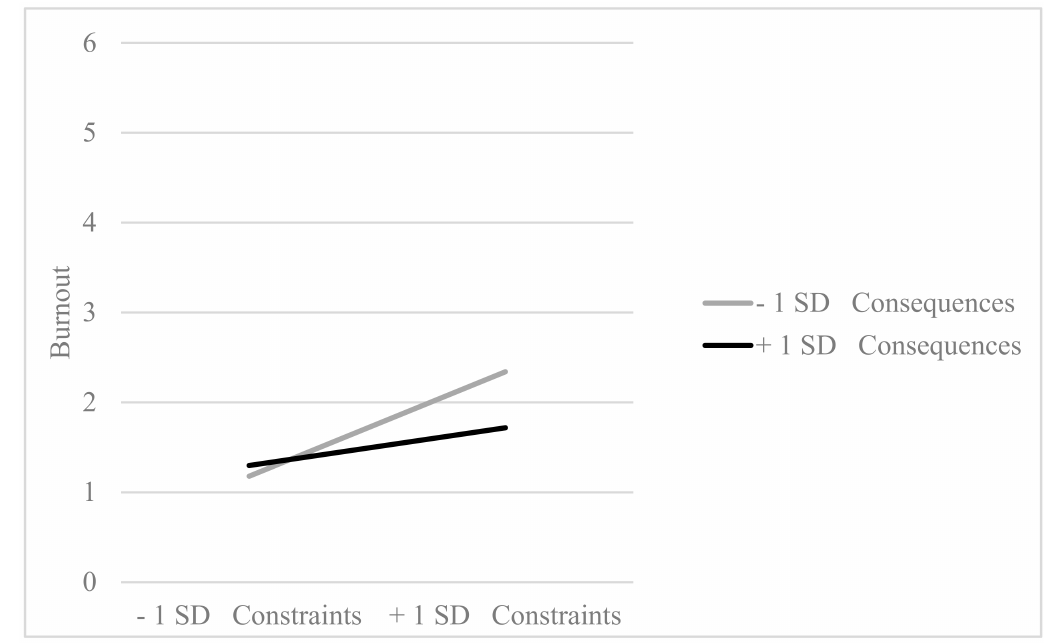
Figure 3. Interaction effect between constraints and consequences in the teachers’ sample ( β = − 0.14, p = 0.011).